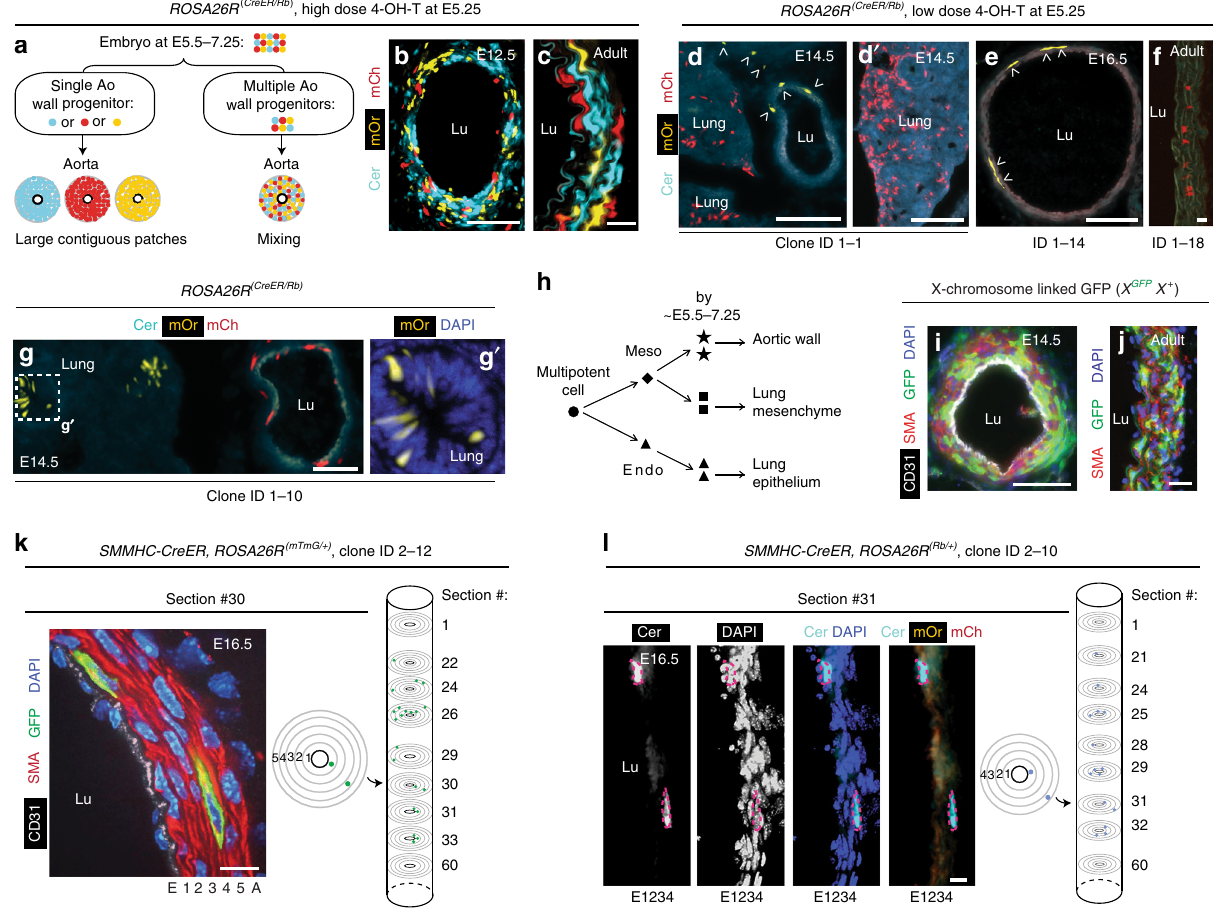
Fig. 1 Aortic SMCs are polyclonal and highly migratory in development. a Cells of ROSA26R ( CreER / Rb ) embryo induced with high dose 4-OH-T at E5.25 are expected to be of multiple colors at E5.5 – 7.25. If the aortic wall derives from a single cell (or instead from multiple polyclonal cells) present at ~E7.25 or thereafter, wall cells will be a single color (or multiple colors). b – g Sections of ROSA26R ( CreER / Rb ) mice in transverse ( b – e , g ) or longitudinal axis ( f ) imaged with direct fl uorescence of Rb channels. At E5.25, dams were induced with a single high 4-OH-T dose in b , c (150 µ g) or, to label clonally, at a limiting dose in d , d ′ (100 µ g; Supplementary Table 1, clone ID1-1), e (20 µ g; ID1-14), f (20 µ g; ID1-18), and g (50 µ g; ID1-10). Arrowheads indicate mOrange + cells ( d , e ), with marked cells in d suggesting ventral migration of aortic progenitors. By the time of recombination, progenitors of aorta and lung mesenchyme ( d , d ′ ) or epithelium ( g , g ′ ) are differentially speci fi ed ( h ) (Supplementary Table 1). i , j Transverse sections of X GFP X + aorta stained for GFP at E14.5 and in the adult (5 weeks), representative of n = 4 embryos and 6 adults. k , l SMMHC - CreER T2 embryos also carrying ROSA26R ( mTmG / + ) or ROSA26R ( Rb / + ) induced with tamoxifen 0.5 mg at E9.5 (when there is one SMC layer; Supplementary Fig. 1b, c) and analyzed at E16.5. In k transverse aortic section (left panel, section #30) of a 21-cell GFP-marked clone (Supplementary Table 2, clone ID2-12; Supplementary Fig. 3) after GFP staining. The middle panel shows positions of two marked cells in this section, and columnar clone schematic (right panel) is a compilation of transverse sections, among 60 consecutive sections analyzed, that contain marked cells. The fi rst and 60th sections are included for reference. A 15-cell clone (ID2-10) is shown in l with the section stained for DAPI and imaged for Rb colors. The clones in k , l expanded radially, circumferentially, and longitudinally. Lu, aortic lumen; E, endothelial layer; 1 – 5, smooth muscle layers; A, adventitial layer. Scale bars, 100 µ m ( b , d , e , g , i ) and 10 µ m ( c , f , j – l